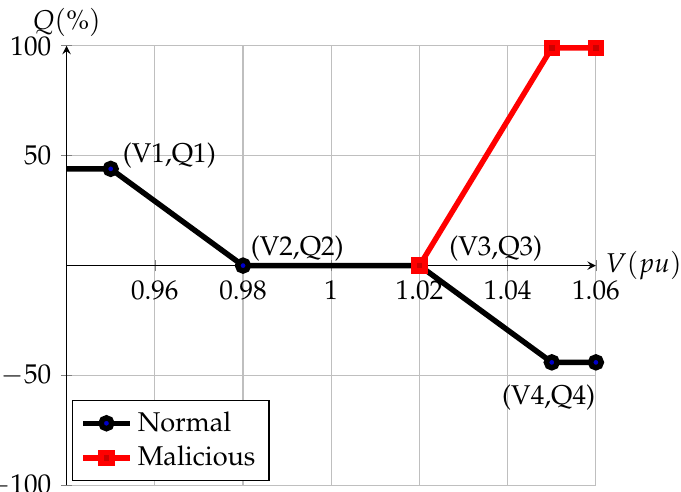
Figure 2. All of the distributed PV inverters used the normal and malicious VVC to emulate good and bad behavior. The normal VVCs defined a negative reactive power when the voltage exceeded 1.02 pu, while the malicious curves dictated a positive reactive